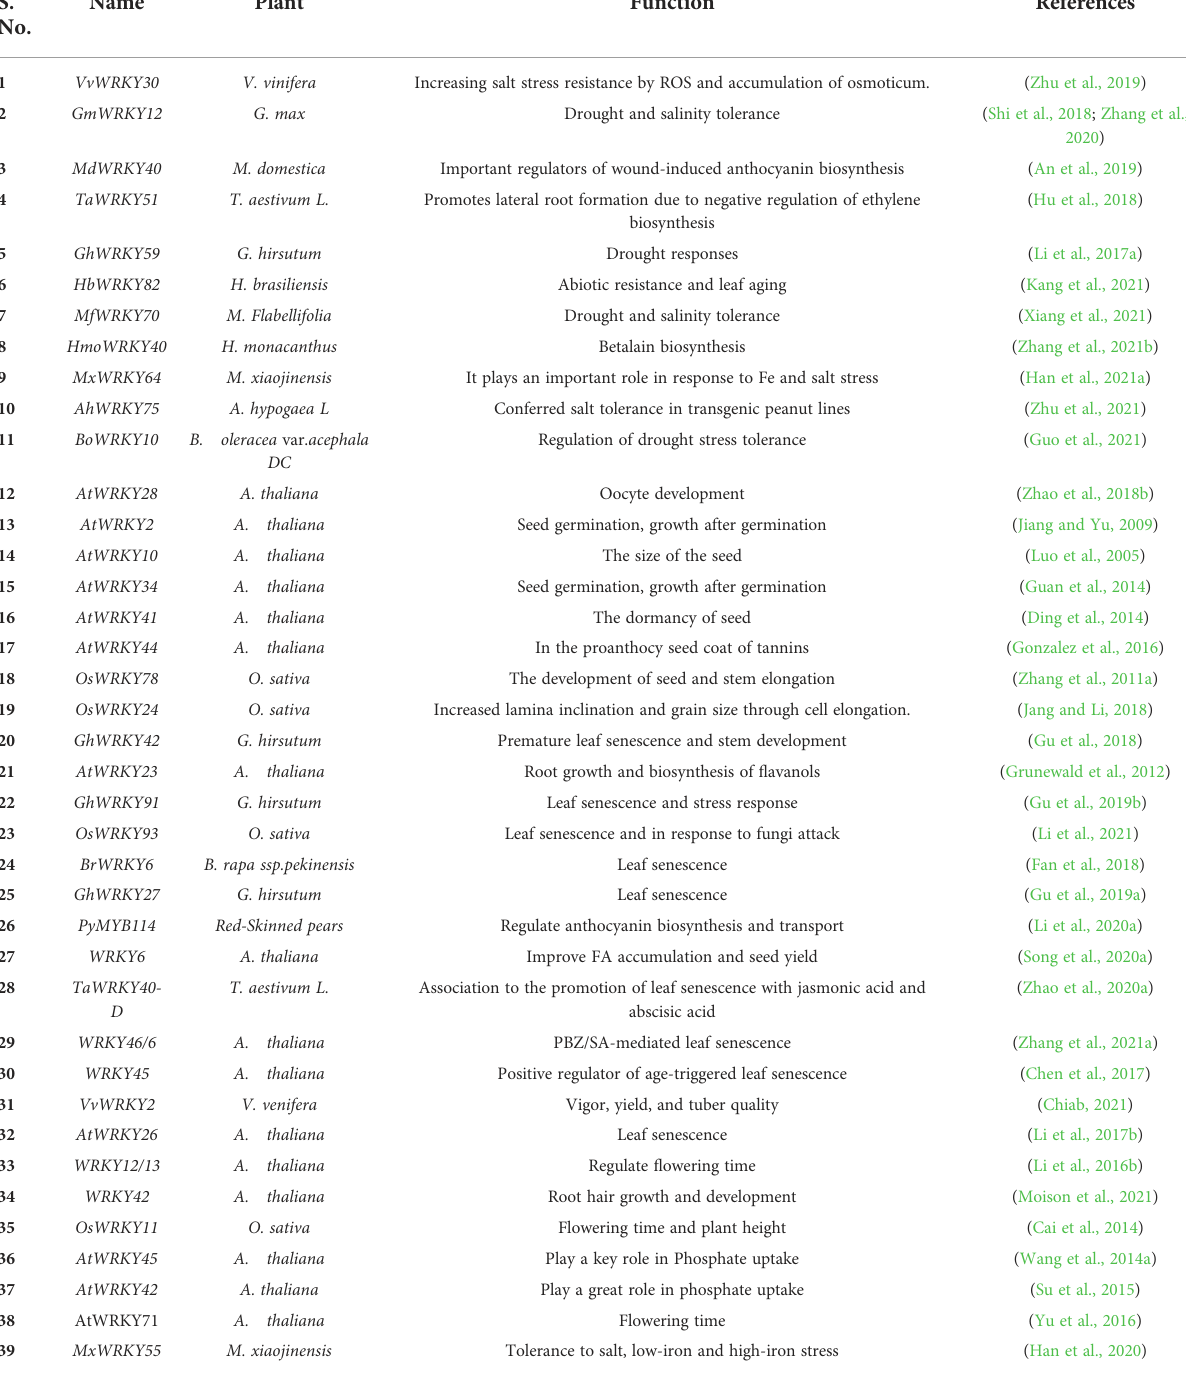
TABLE 6 Role of WRKY TFs in plant growth and development.